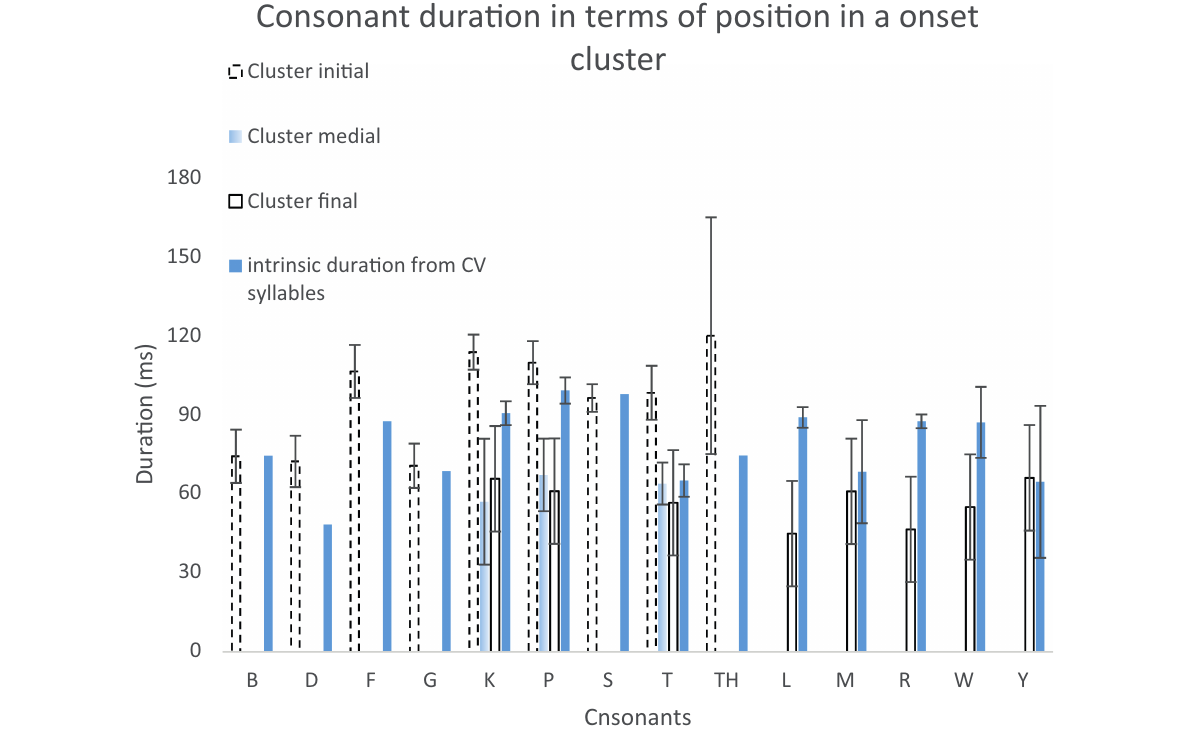
FIGURE 7 Consonant duration in initial, medial, final position in onset consonant clusters or as singletons, compared to the intrinsic durations of the same consonants calculated from CV syllables. CCCVC, CCCVCC, CCVC, CCVCC, CCVCCC syllables are pooled